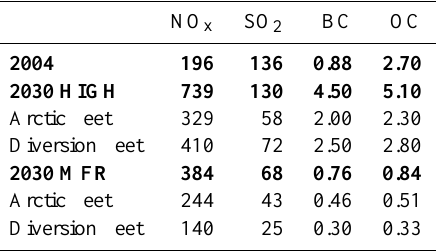
Table 1a. Ship emissions north of 60 ◦ N in 2004 and 2030 (Ktonyr − 1 ) from Corbett et al. (2010a). There is seasonal variation in the emissions from the Arctic fleet. The diversion fleet operates in the period August–October. Numbers in bold are total emission each year, numbers in normal font are emissions for the sections of the total fleet. NO x SO 2 BC OC